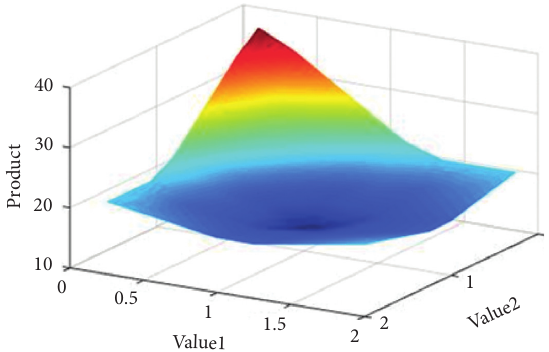
Figure 9: GM-BPANN